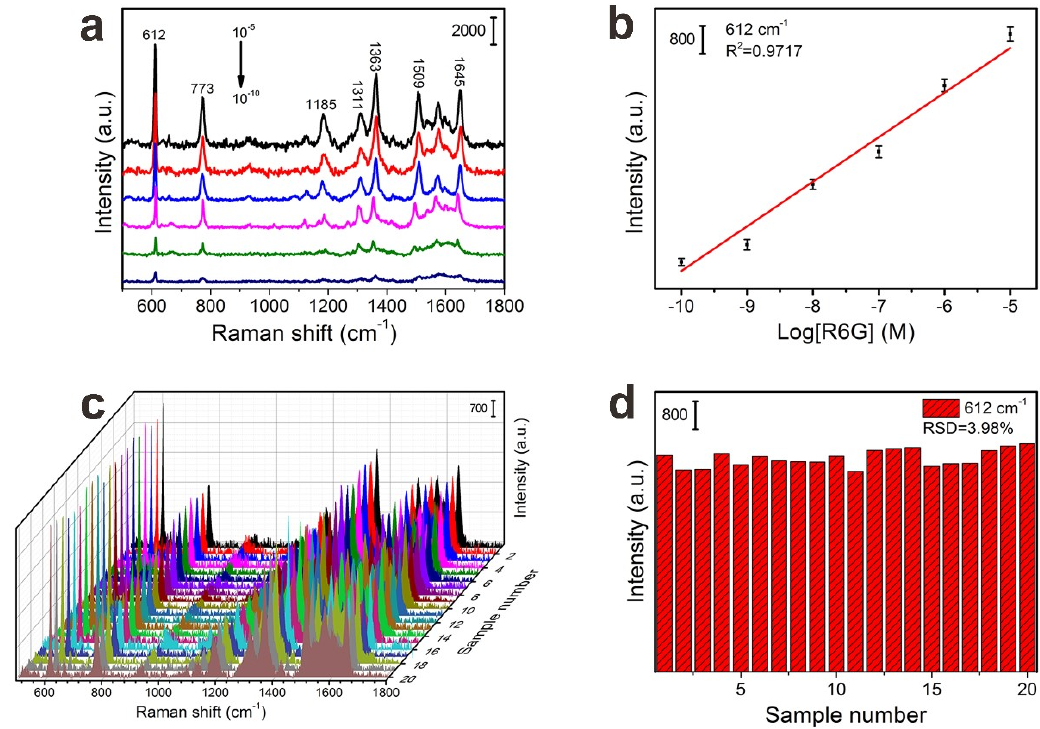
Figure 6. ( a ) Spectra of R6G with 10 − 5 M, 10 − 6 M, 10 − 7 M, 10 − 8 M, 10 − 9 M and 10 − 10 M concentrations, collected from the respective FP@PDA@AgNPs strips. ( b ) The linear relationship between the Raman intensity at 612 cm − 1 and the logarithm values of R6G concentration from 10 − 5 to 10 − 10 M. ( c ) SERS spectra of 10 − 6 M R6G collected from 20 randomly selected spots on the FP@PDA@AgNPs strips. ( d ) Intensity distribution of characteristic Raman peaks at 612 cm − 1 .